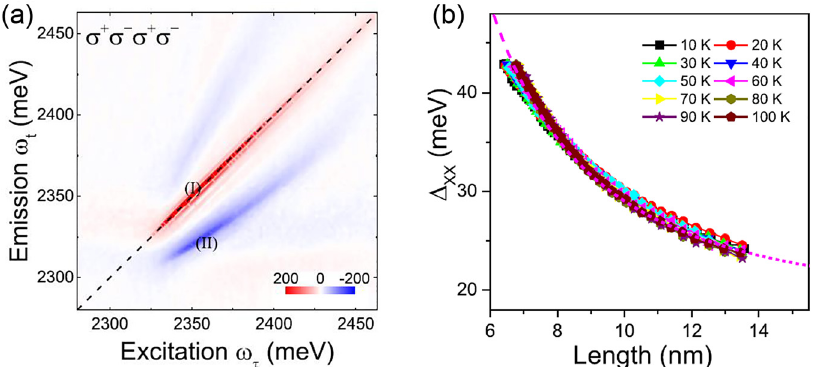
Figure 7: (a) Real part of rephasing 2D spectra of CsPbBr 3 nanocrystals at 10 K with the cross-circularly polarized excita- tion con fi guration. (b) Biexciton binding energy ( Δ XX ) as a function of nanocrystal size using the effective mass approxima- tion. Reproduced with permission